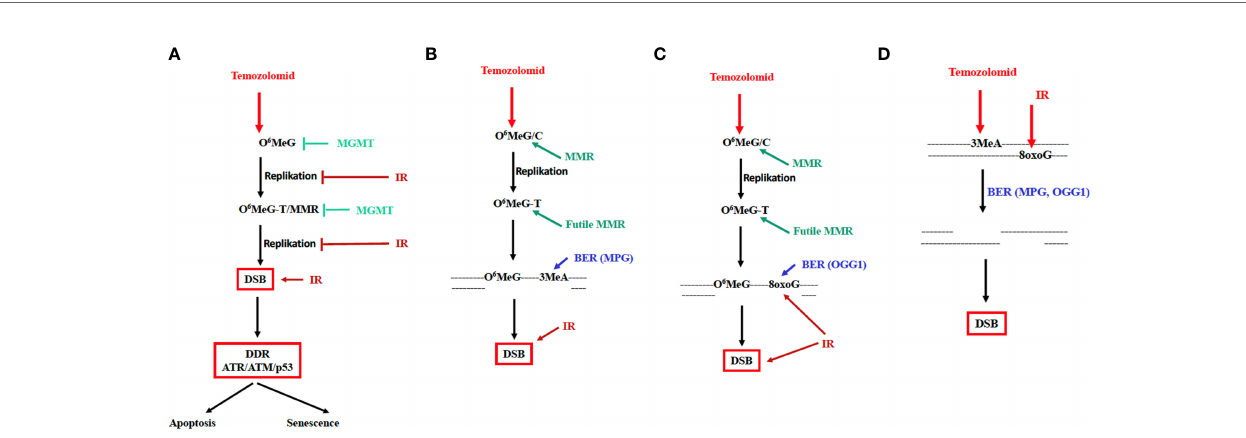
FIGURE 2 | Mechanism of TMZ-induced cytotoxicity and cellular senescence and possible mode of interaction of TMZ and IR. MGMT and IR inhibiting the cytotoxic pathway are indicated. DDR: DNA damage response involving the kinases ATR, ATM and the transcription factor p53. (A) Genotoxic pathway triggered by O 6 MeG; futile MMR cycle model. (B) MMR and BER of N-methylation lesions cooperate in inducing DSBs. (C) MMR and BER of oxidative lesions cooperate in inducing DSBs. (D) DSBs are formed in overlapping base excision repair patches of lesions induced by TMZ and radiation. BER, long-patch base excision repair; MPG, N- methylpurine-DNA glycosylase; OGG1, 8-oxo-guanine-DNA